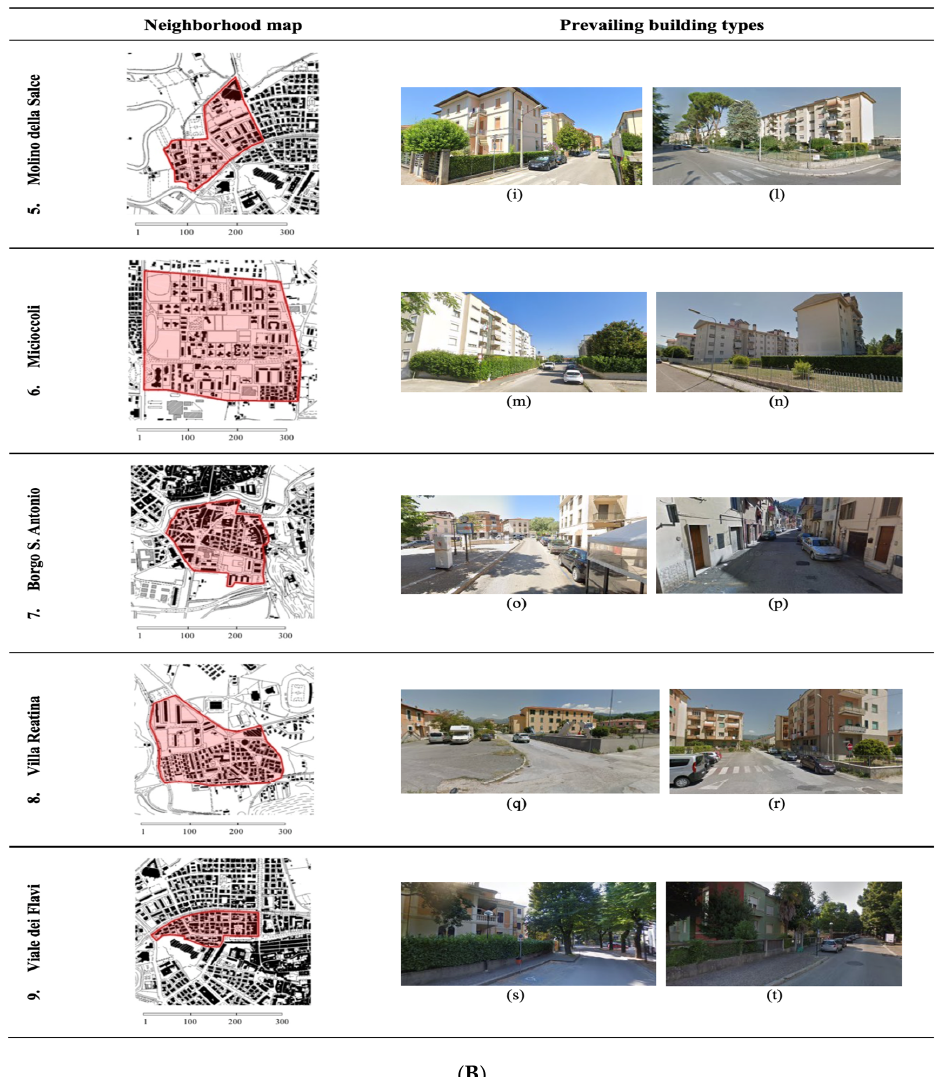
Figure 3. ( A ) Neighborhood map and prevailing building types of Città Giardino (1—a,b),